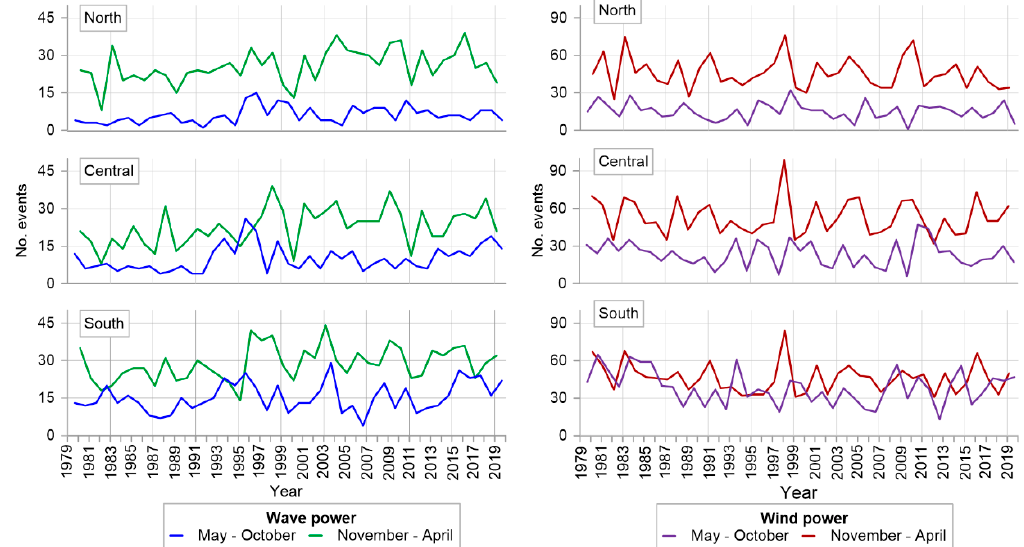
Figure 4. Number of events in which wave power exceeded 10 kW / m ( left ) and wind power exceeded 0.5 kW / m 2 ( right ) over six-month periods (May–October and November–April) from January 1979 to December 2019, for three points along the Mexican Caribbean (see Figure 2). Data obtained from Era5 climate reanalysis [22] .